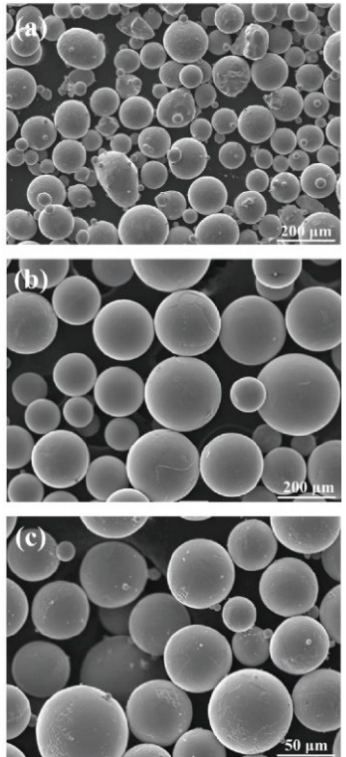
Figure 32. Surface micrographs of Ti-6Al-4V powders by different methods: ( a ) GA; ( b ) PREP; ( c ) PA [81].